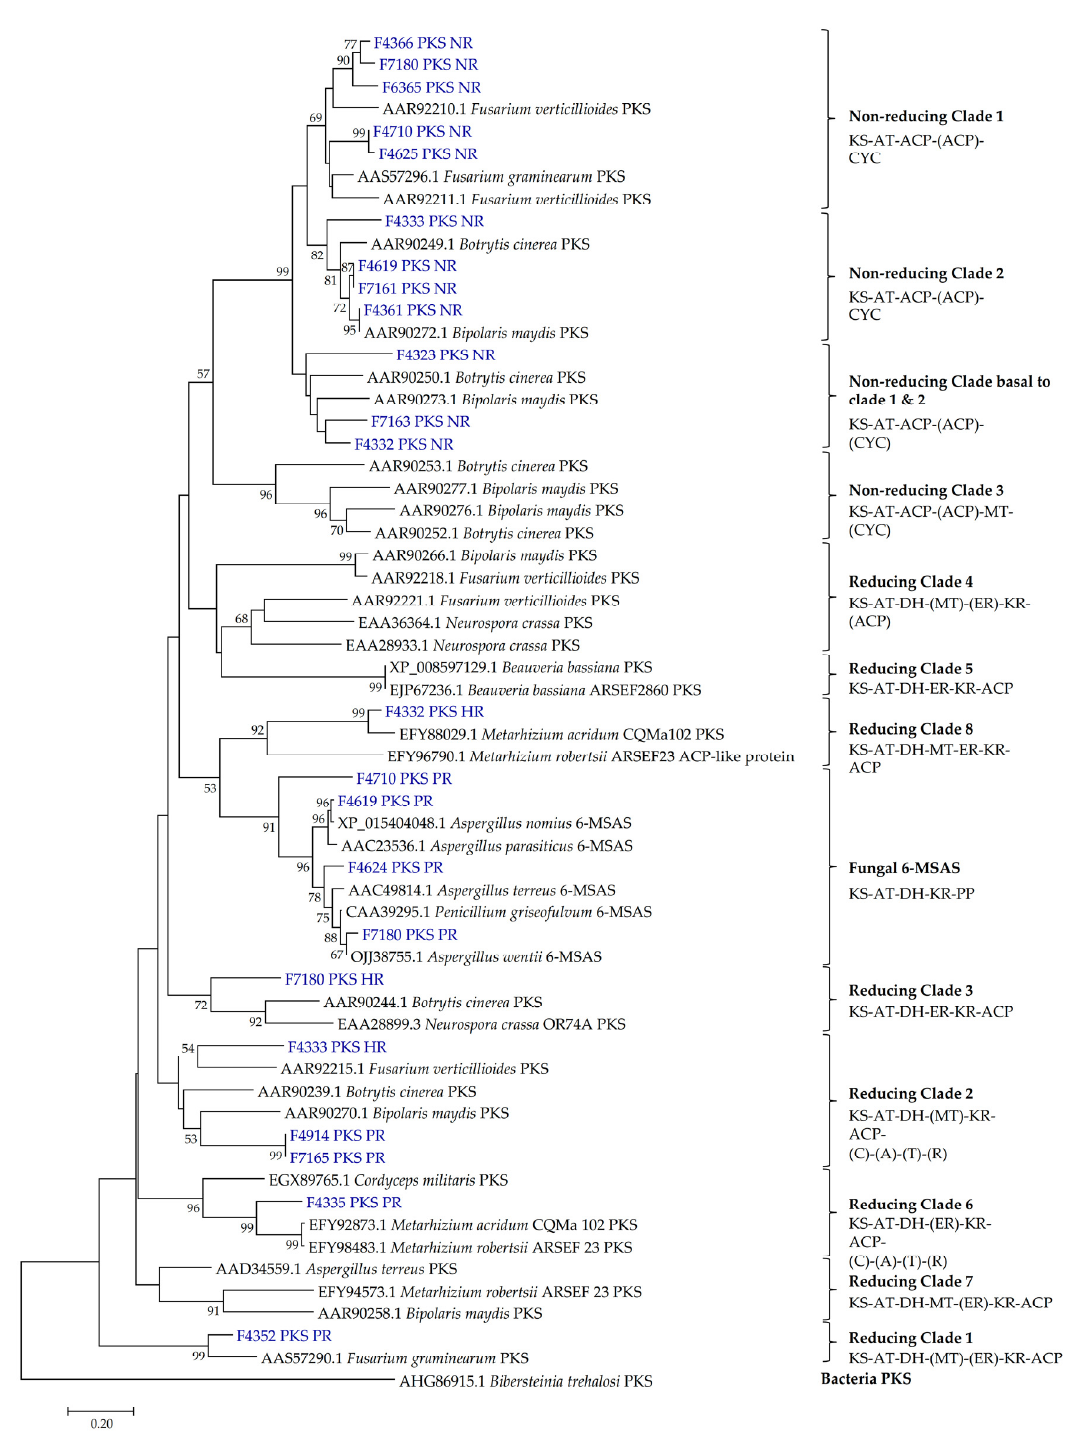
Figure 2. The phylogenetic tree of the ketosynthase domains of fungal polyketide synthases (PKSs) detected in this study (shown in blue). Reference PKS sequences of known clades were obtained from previous reports [43,44]. The common organization of domains is indicated with the clades. Domains in parentheses are variable in their presence/absence within the respective clades. GenBank accession numbers are shown beside each reference entry. A bacteria PKS from Bibersteinia trehalosi was used as an outgroup. Evolutionary relationships were determined by the neighbor-joining method, and bootstrap values of ≥ 50% are shown above the nodes. The scale bar represents 0.2 amino acid